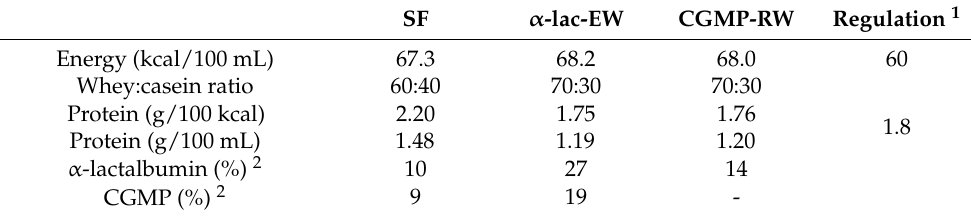
Supplement Table S2. Detailed instructions on how to prepare the infant formulas were given to the parents both orally and in writing. Table 1. Energy and protein content in study formulas * and minimum levels according to